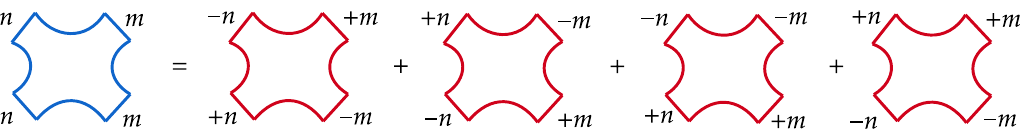
Figure 2 . Inelastic scattering amplitude of ( n, n ) → ( m, m ) for massive KK open strings with Z -even parity (blue color) can be decomposed to a sum of four sub-amplitudes of massive KK 2 open strings (red color) under the S 1 compactification of 26d for bosonic